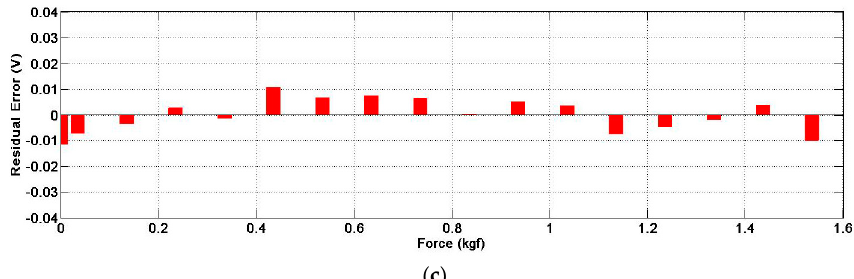
Figure 4. The force-voltage curve, the fitting line and the residual error of force sensing. ( a ) the force-voltage curve; ( b ) the fitting line in the range of good linearity; ( c ) the residual error.